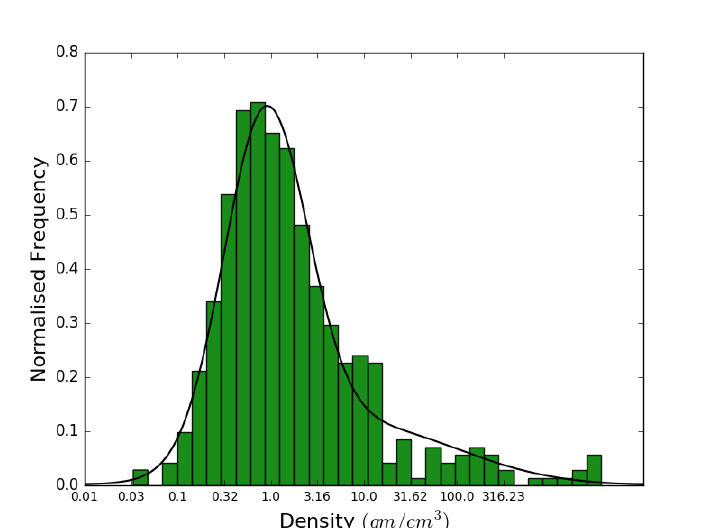
Figure 2. The GMM based fit for the density of the exoplanets using the best-fit parameters from Eq. 6 for k = 2. Details of the fit can be found in Tab.